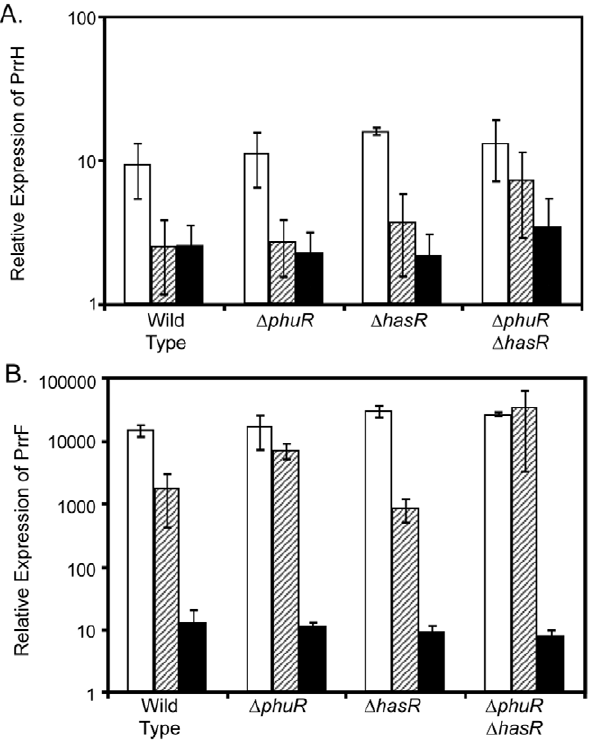
Figure 6. PhuR and HasR are important for heme regulation of PrrH. Heme utilization mutants lacking one or both outer membrane heme receptors were grown for 18 hours in CM9 + 1% glycerol with no added iron (white bars), 40 m M hemin (hatched bars), or 100 m g/ml FeCl 3 (black bars). RNA was then isolated and analyzed by qRT-PCR, as described in the Materials and Methods, for the mutants’ ability to mediate heme and iron regulation of the PrrH (A) and PrrF (B) RNAs. Error bars show the standard deviation of at least three independent